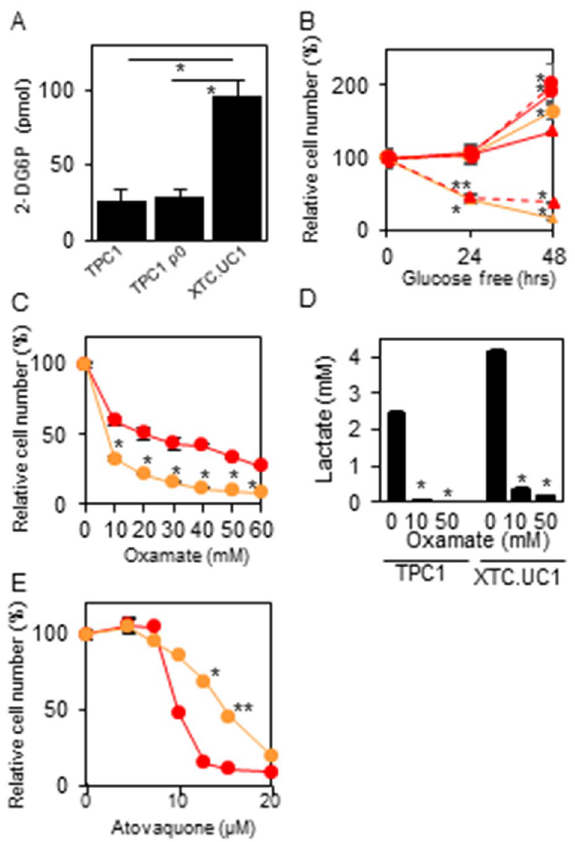
Figure 3. Glucose uptake ( A ), relative cell numbers in cells cultured in the presence and absence of glucose ( B ), with oxamate ( C ) or atovaquone ( E ), and the effect of oxamate on lactate production ( D ). Glucose uptake, cell number measurements and lactate measurements were performed as described in the “Materials and methods”; briefly, in ( C – E ), the cells were treated with 10–60 mM oxamate or 5–20 μM atovaquone for 48 h. In ( B ), red circles with solid lines, TPC1/glucose ( +); red triangles with solid lines, TPC1/glucose free; red circles with broken lines, TPC1 ρ0 cells/glucose ( +); red triangles with broken lines, TPC1 ρ0 cells/glucose free; yellow circles, XTC.UC1/glucose ( +); yellow triangles, XTC.UC1/glucose free. In ( C , E ): red, TPC1; yellow, XTC.UC1 cells. Data are presented as means ± SE. In ( B ): * and **, p < 0.01 and 0.05, respectively, vs. 0 h; in ( A ) and ( B – D ): *, p < 0.01; **, p <